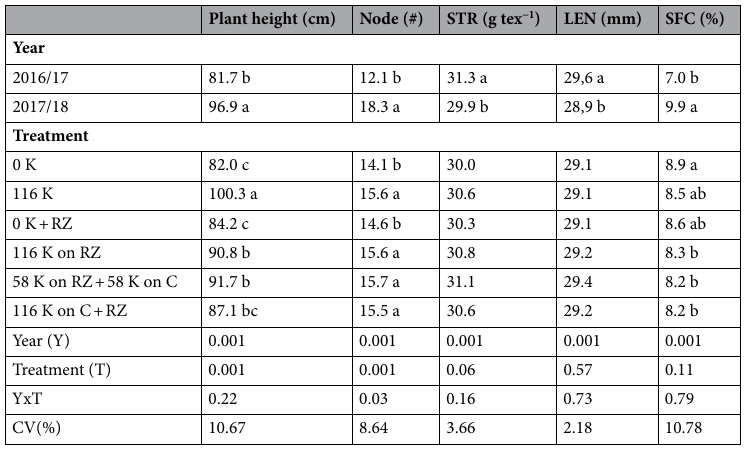
Table 1. Yield components and fiber strength (STR), length (LEN) and short fiber content (SFC) of cotton cultivars as affected by year and potassium management. MIC micronaire, STR strength, LEN length, SFC short fiber content.